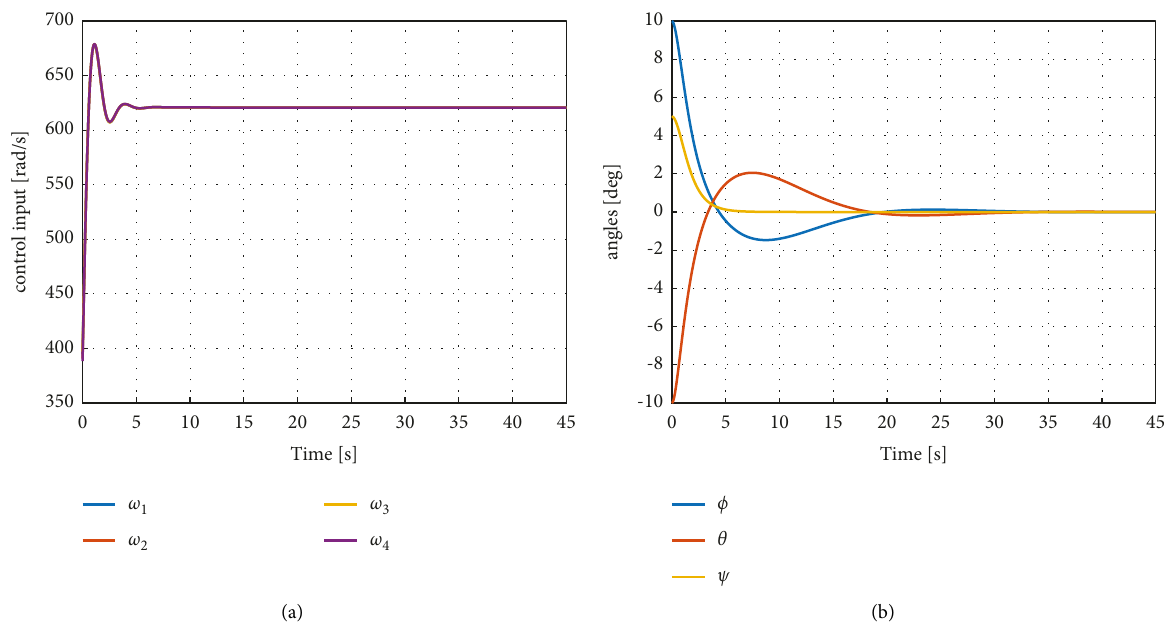
Figure 9: Control input and angles ϕ , θ , and ψ with an additional proportional controller gain k to drive the system states to zero.